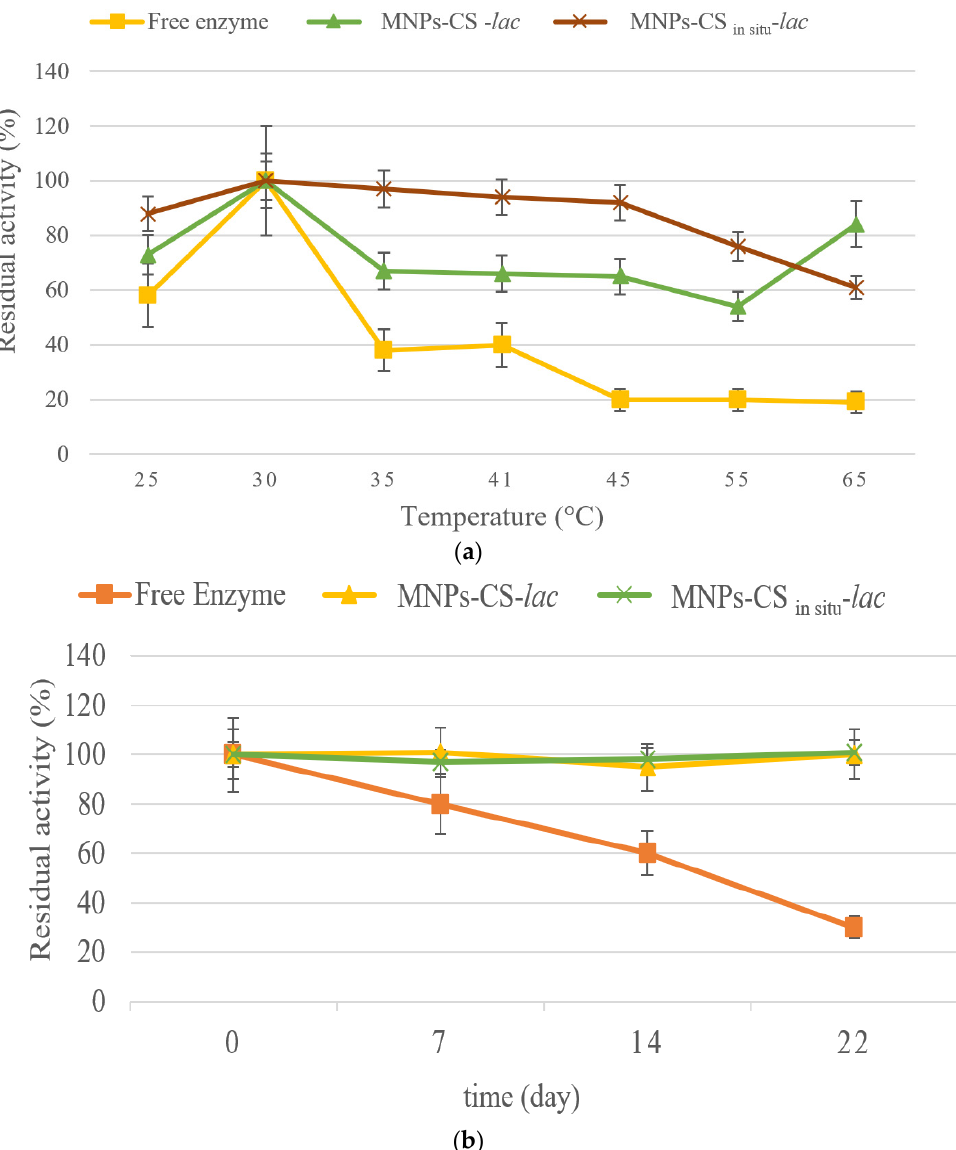
Figure 6. Residual activity as a function of temperature ( a ) and time stability ( b ) of free and covalently immobilized laccase onto MNPs-CS and MNPs-CS in situ systems.